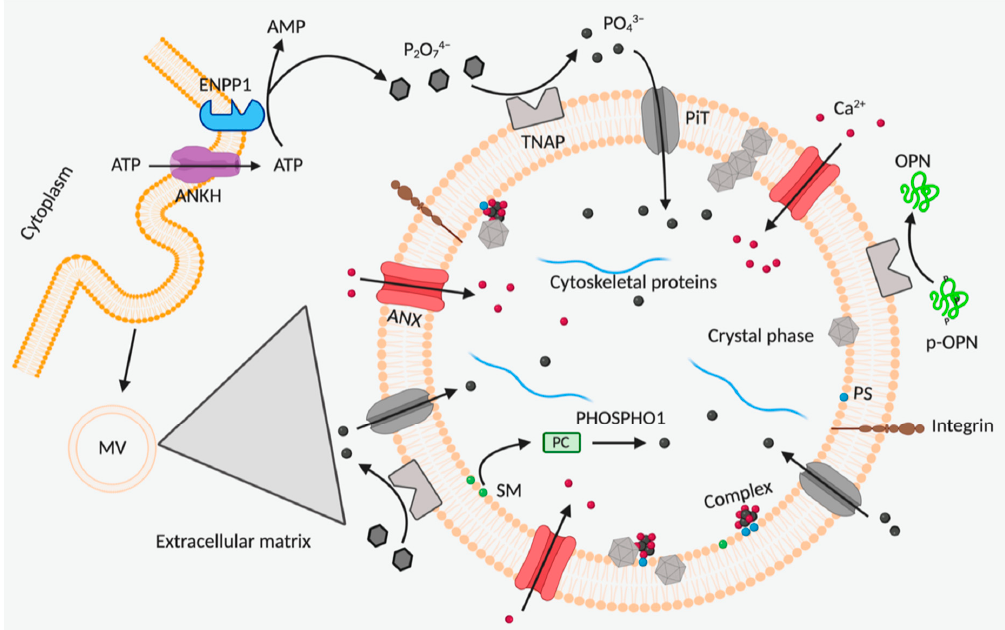
Figure 1. MVs. Mineral deposition is initiated by accumulation of calcium (Ca 2+ ) and inorganic phosphate (PO 43 − ) into matrix vesicles (MVs) (for more details see the text) Abbreviations: ANKH = progressive ankylosis protein homolog, ANX = annexin; ENPP1 = nucleotide pyrophosphatase phosphodiesterase; OPN = osteopontin; PC = phosphocholine; PiT = phosphate transporter; P 2 O 74 − = pyrophosphate; PS = phosphatidylserine; TNAP = tissue non-specific alkaline phosphatase; SM = sphingomyelin.